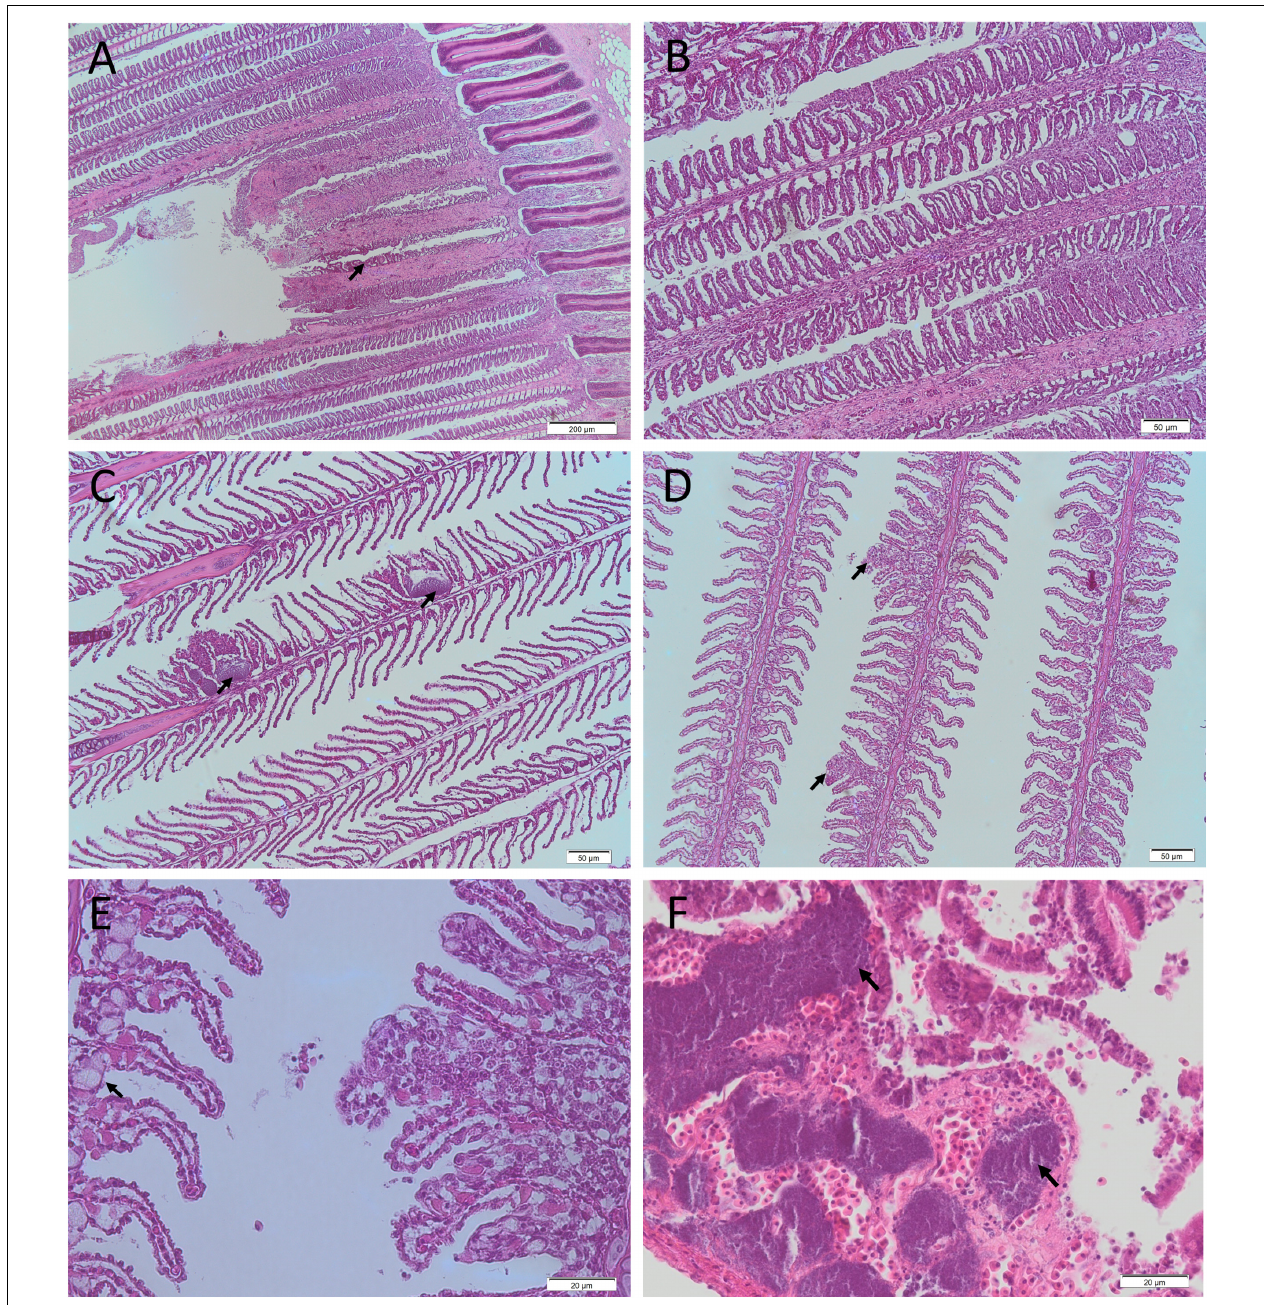
FIGURE 7 | Representative histological photomicrographs of fish gills (A–E) and kidney (F) from the 2013 fish kill. Necrotic gill lesion with gill filaments severely affected and associated hemorrhage ( A ; arrow; 4 × magnification [mag.]), gill congestion ( B ; 10 × mag.) and focal gill lesions with associated bacteria ( C ; arrow; 10 × mag.) in a Sweep ( Scorpis spp.) collected on the 4/04/2013. Focal hyperplastic gill lesions ( D ; arrows; 10 × mag.) and focal hyperplastic gill lesion with associated mucous cell hyperplasia observed on adjacent gill filament ( E ; arrow; 40 × mag.) in an Ornate Cowfish ( Aracana ornate ) collected on the 3/04/2013. Kidney with numerous bacterial emboli (arrows; F ; 40 × mag.) in a Hulafish ( Trachinops spp.) collected on